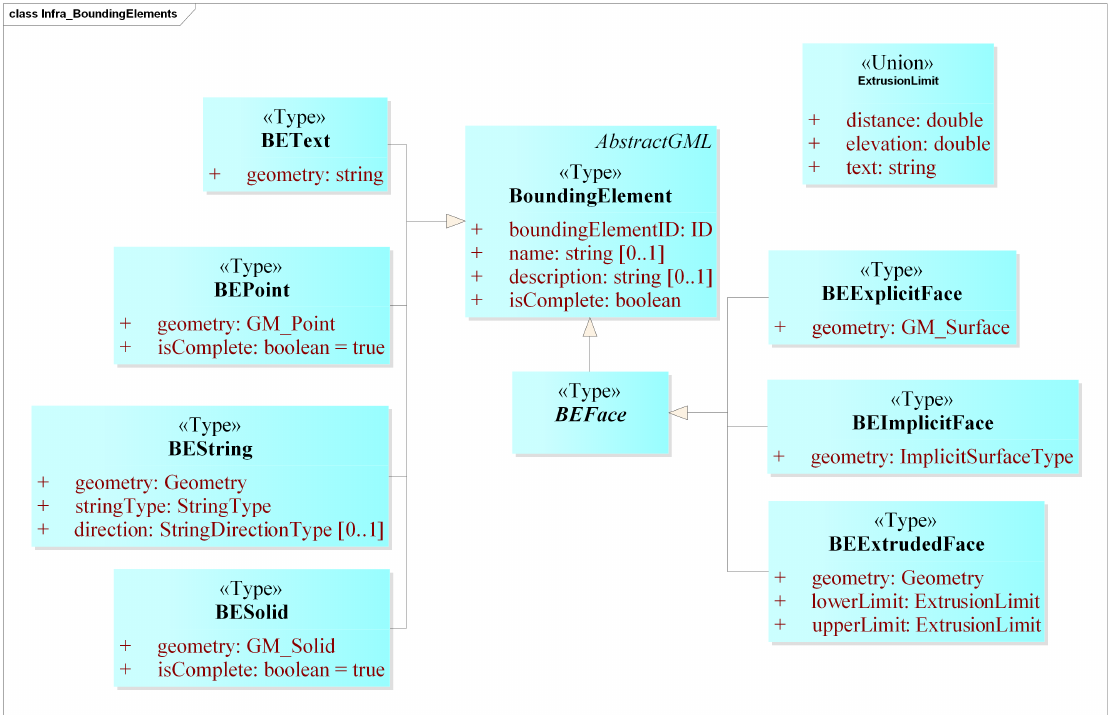
Figure A4. The UML excerpt depicts the LandInfra BoundingElement(s) to specify the boundary of the spatial units in the CityGML Infra